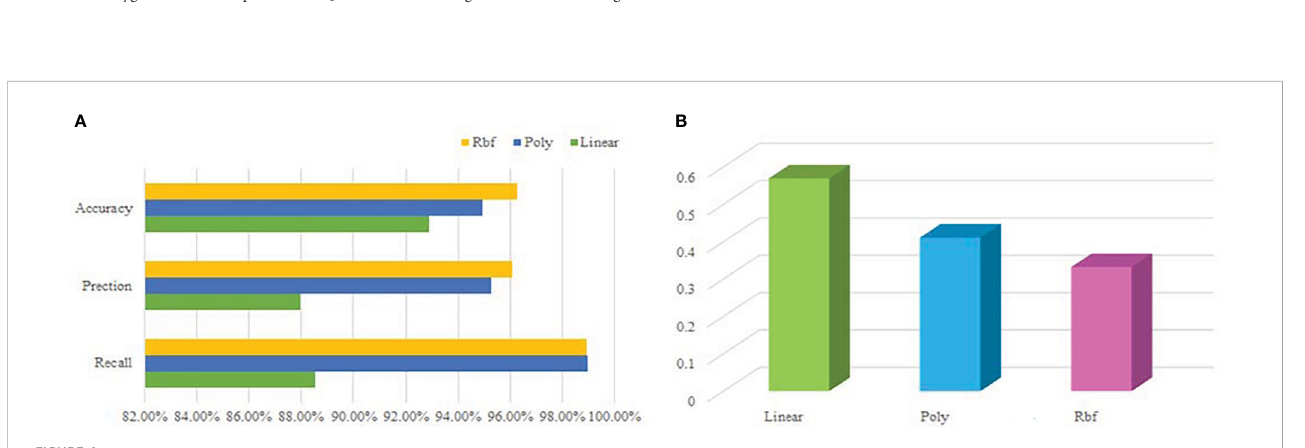
FIGURE 4 Results of different kernel function choices (A) Accuracy, precision and recall of model (B) RMSE for model.